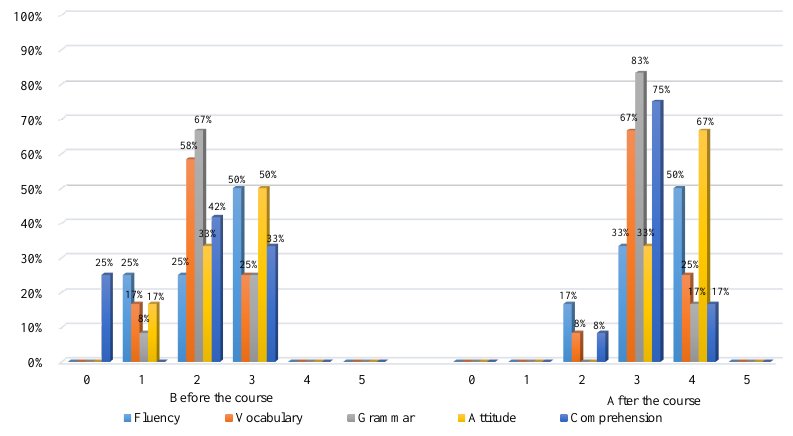
Fig. 3. Comparison between before and after the online course design